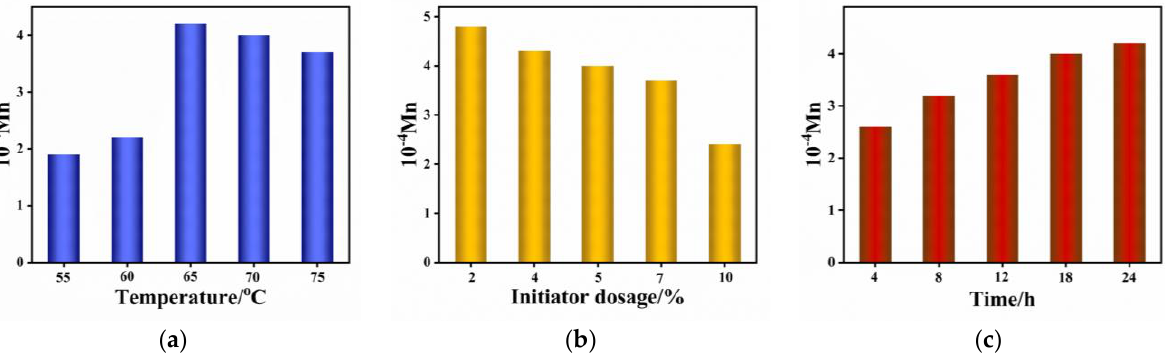
Figure 2. Effect of ( a ) temperature, ( b ) initiator dosage, ( c ) time on the molecular weight of copolmers .